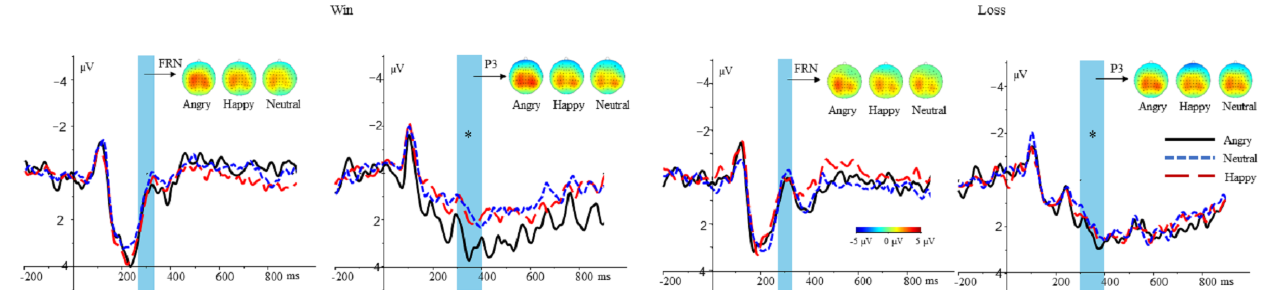
Figure 3. Grand averages according to the feedback stages. Grand average ERPs (FRN on electrode Fz and P3 on electrode Pz) for win and loss, separated by happy, angry, and neutral faces. *: p < 0.05.